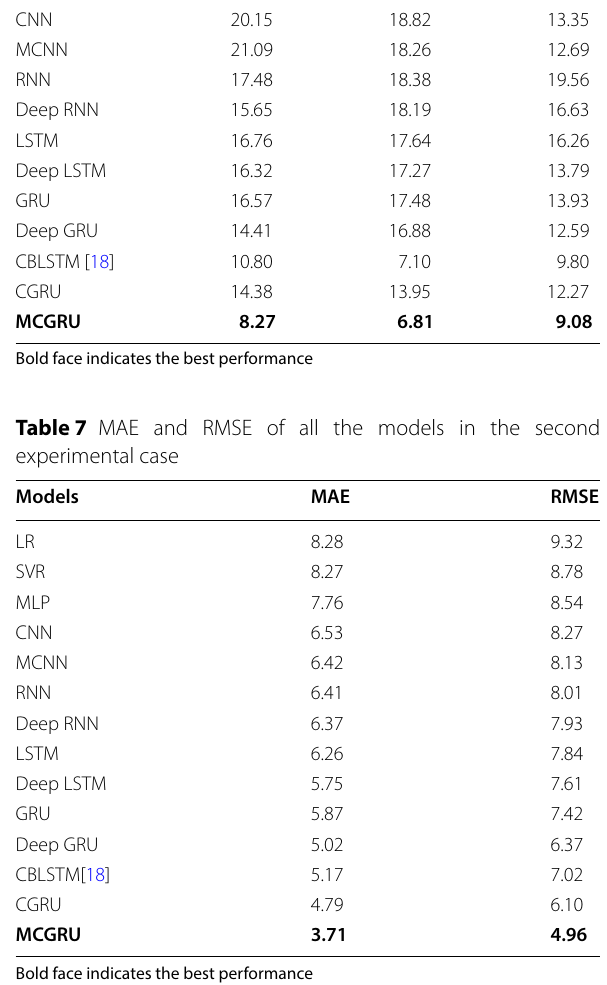
Bold face indicates the best performance